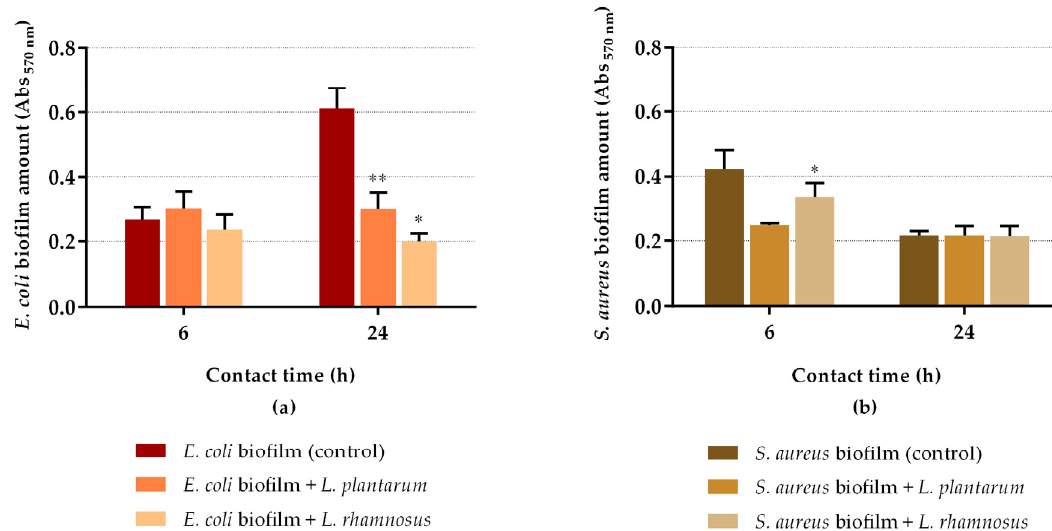
Figure 3. Total amount of E. coli ( a ) and S. aureus ( b ) biofilms after 6 h and 24 h of contact with probiotics ( L. plantarum or L. rhamnosus ). The data present the mean and SD of at least three independent experiments. Statistically significant differences between the control and treatment were considered for p -values < 0.05 (* and ** indicate p < 0.05 and p < 0.01, respec- tively).